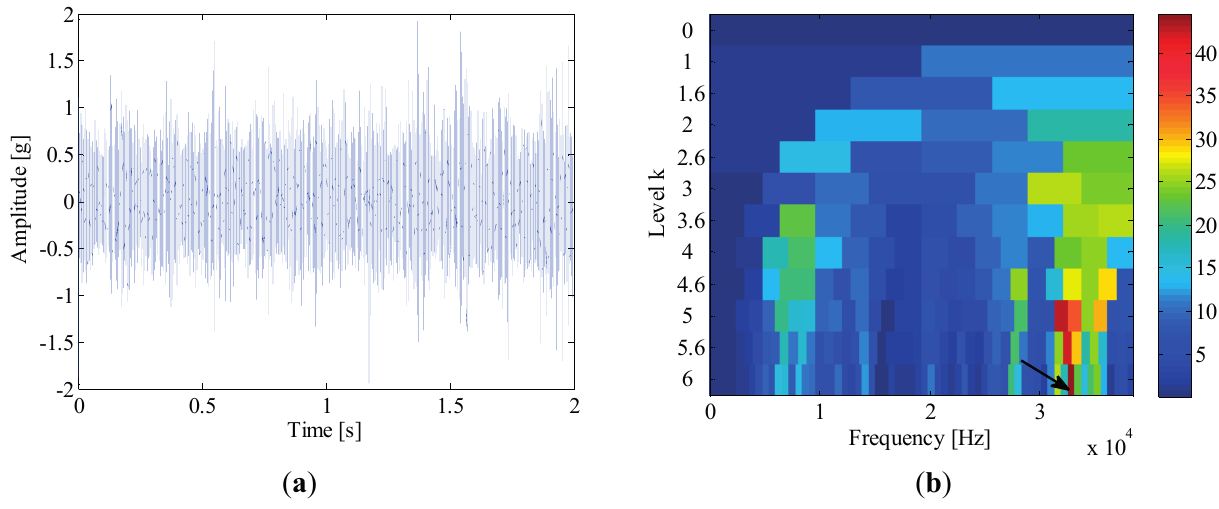
Figure 16. ( a ) Waveform and ( b ) kurtogram of the bearing signal.